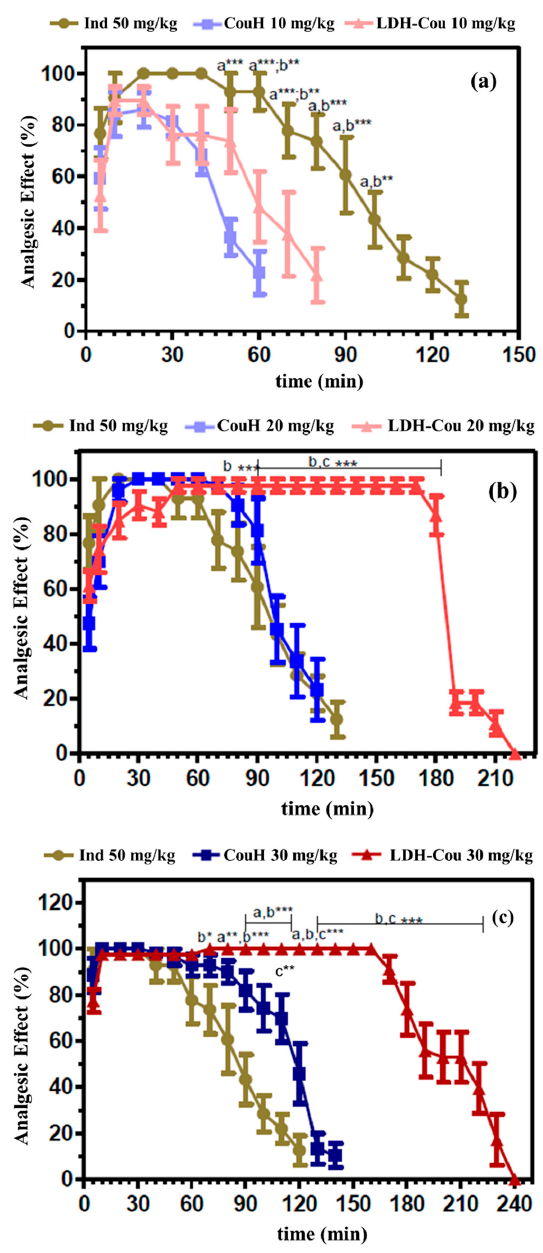
Figure 9. Profiles with maximum percentage of the analgesic effect versus time obtained after treat- ment with CouH or LDH-Cou, in the doses 10 mg/kg ( a ), 20 mg/kg ( b ) and 30 mg/kg ( c ), trough the tail-flick test. Statistics: a—Ind vs. CouH; b—Ind vs. LDH-Cou; c—CouH vs. LDH-Cou; * p < 0.05; ** p < 0.001; and *** p < 0.0001, two-way ANOVA (average ± SEM, n = 7/group). The analgesic activity of CouH, LDH-Cou, and Ind was summarized in Table 1 by the values of the area under the curve (AUC 0-240 ) and time of anaesthesia recovery (T rec ).